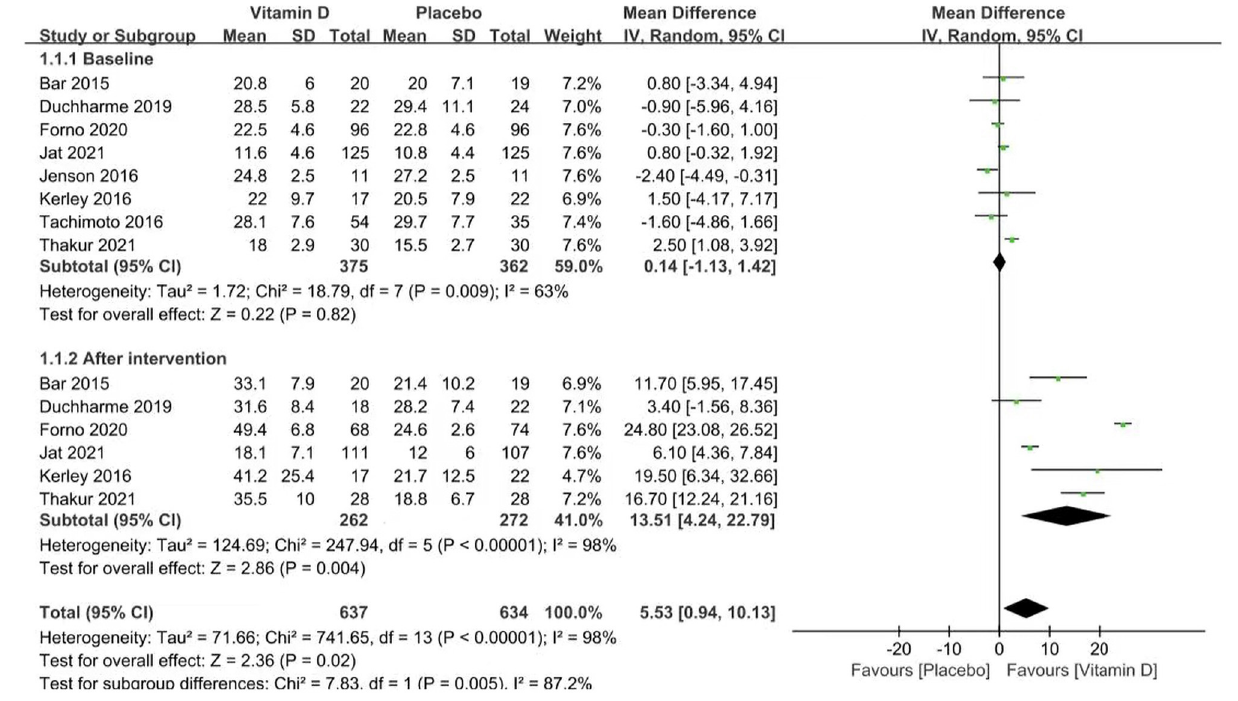
vitamin D levels ( Supplementary Figure S4A ) and FEV1% ( Supplementary Figure S4B ) were stable and